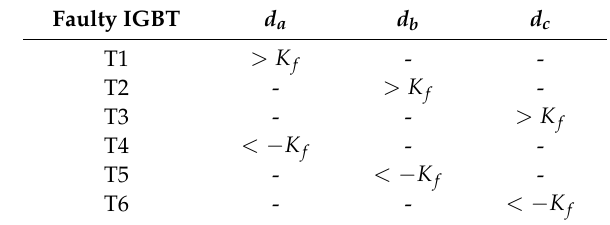
Table 1. Localization of the open circuit fault. IGBT: Insulated Gate Bipolar Transistor. Faulty